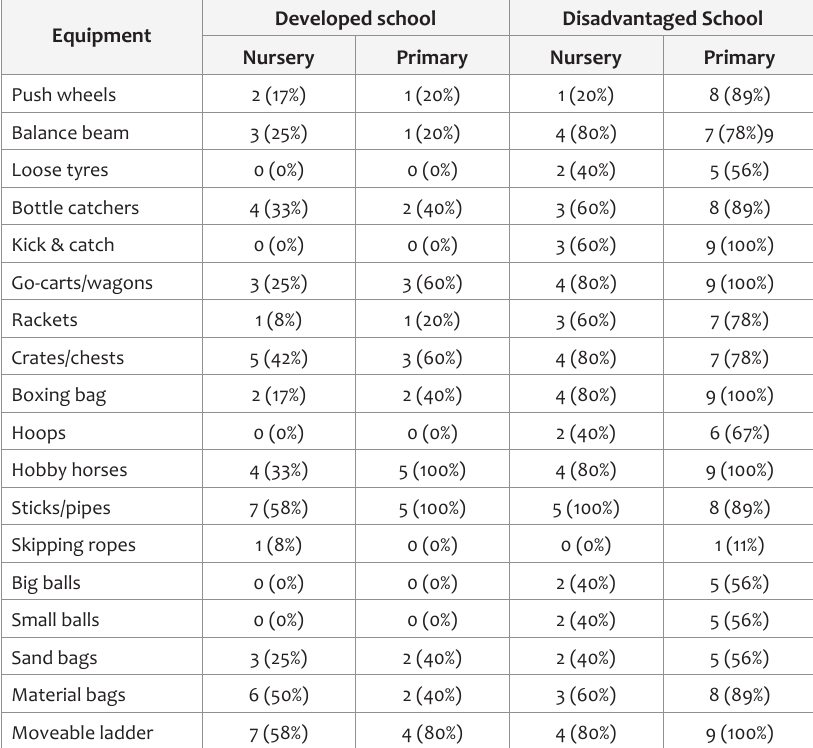
Table 3: Number and percentage of schools that do not possess any loose equipment Equipment